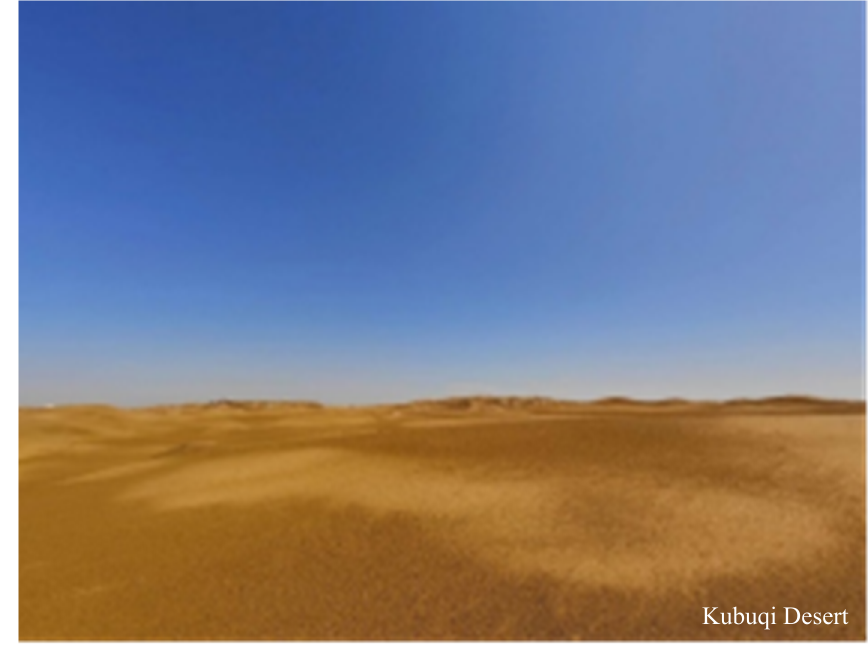
Figure 5. An image of Kubuqi Desert.